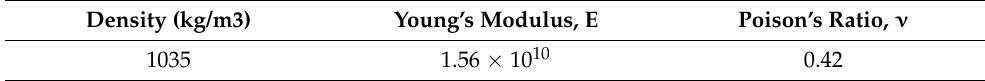
Table 2. Blade material properties (assumed stiffness) [32].